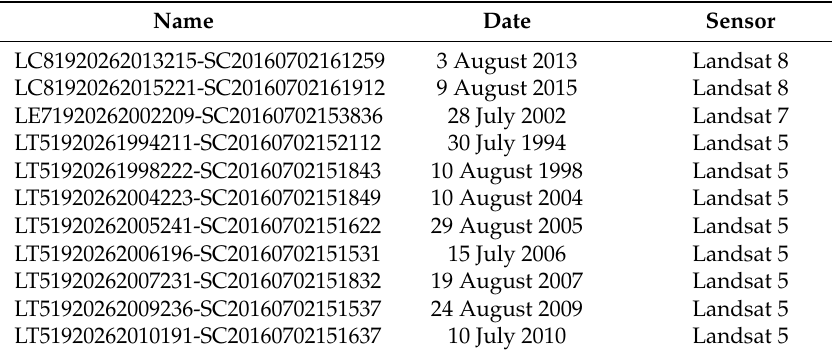
Table 4. Overview of the used Landsat images in the Sumava